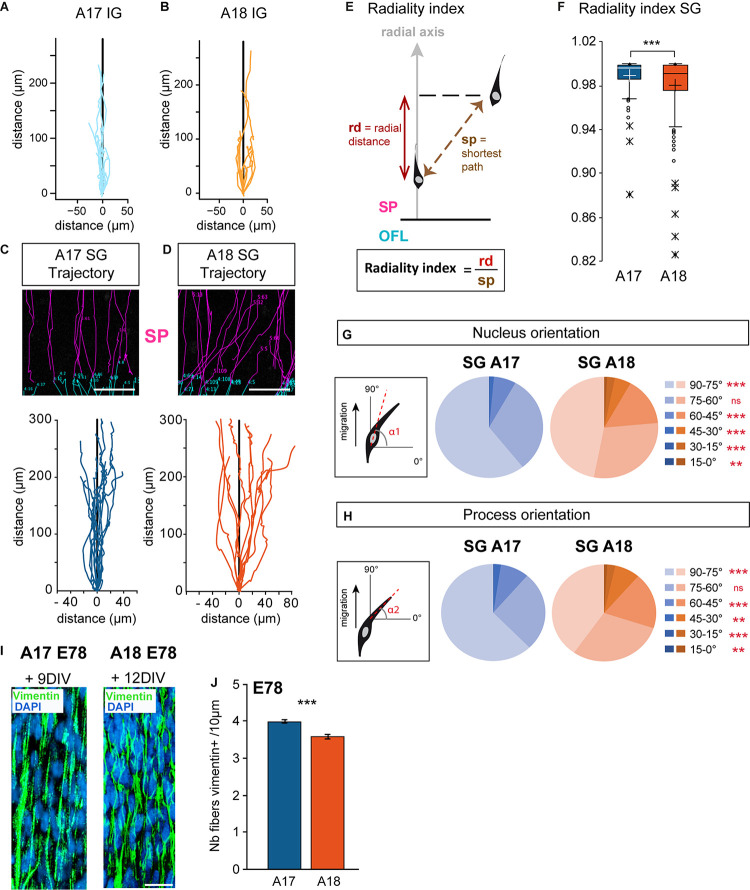
(A,B) Trajectories of migrating IG neurons observed in Area 17 and A18 SP using 2-photon TLV on organotypic slices. (C,D) Typical radial Area 17 and ab-radial Area18 SG trajectories observed in the SP up to 12 days after retroviral infection. Examples of original SP trackings are presented above the graphs. (E) Radiality index. The radiality index corresponds to the ratio between the radial distance (rd) and the distance corresponding to the shortest path (sp) measured between two positions. (F) A17 and A18 SG neurons radiality index. Black and white crosses indicate the mean. (G,H) Nucleus and leading process changes in orientation during A17 and A18 SG trajectories. Nucleus (G) and leading process (H) orientations are defined with respect to the surface of the OFL (= 0°) and measured for each recorded position. (I) Vimentin expression on A17 and A18 in the lower SP during SG migration, as shown after immunofluorescent labeling on 80 microns thick section from E78 organotypic slices at, respectively, 9–12 days after infection. Nuclei are stained by DAPI. Note the well-preserved radial scaffold. (J) Graph showing the density of Vimentin+ fibers in the SP of area 17 and Area 18 per surface area quantified on 20 micron thick sections from E78 cortex. Average values ± sem. Statistical analysis: (F,J) Two-tailed and unequal variance Student test, p values <0.005***. (G,H) GLM test, p values <0.01**, <0.001***. SP: subplate. Scale bars: C,D = 100 μm, I = 20 μm.